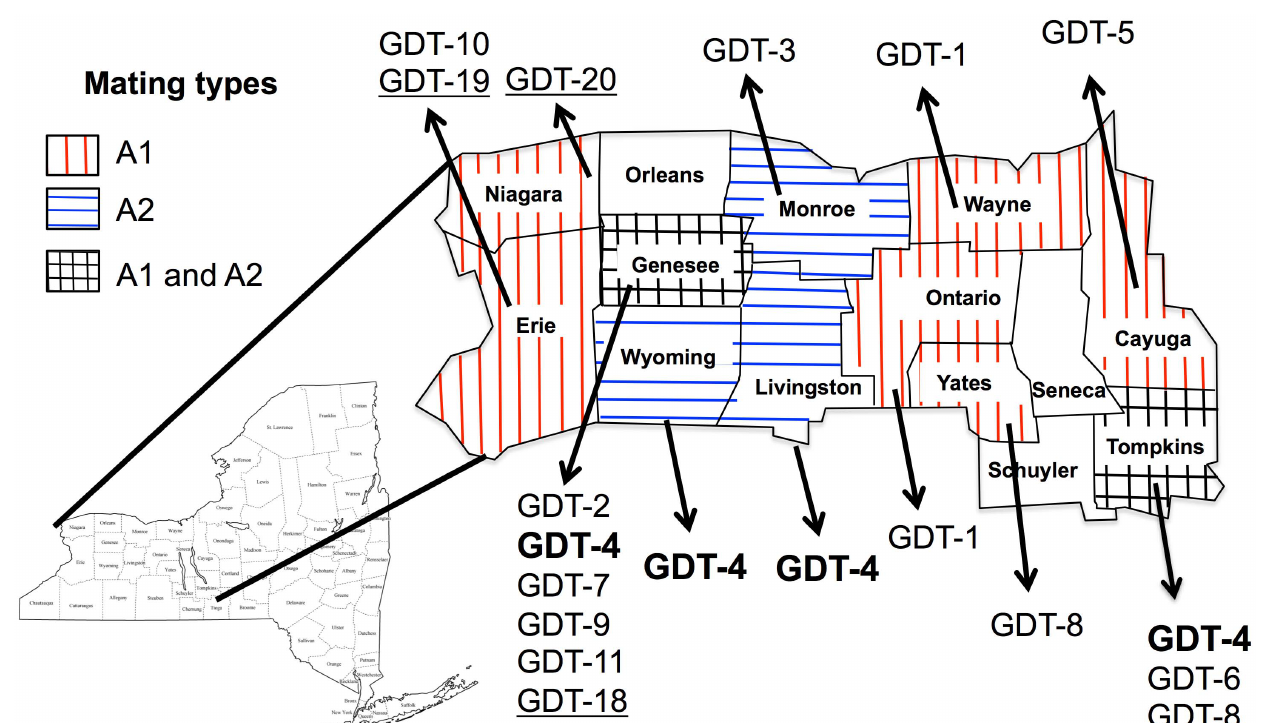
Fig. 1. Spatial occurrence of the NYS-2010/11 population of Phytophthora infestans detected in western New York State. Genotypes that are underlined are those detected in 2010 all other genotypes were detected in 2011. Genotypes shown in bold are those that were found in several counties (GDT-01, GDT-04, and GDT-08). In New York State we detected only A1 individuals in six counties, and only A2 individuals in another three counties. However, both A1 and A2 individuals were reported from yet two other counties. Because of our limited sample size, we cannot conclude with certainty that both mating types were not present in counties where only a single mating type was